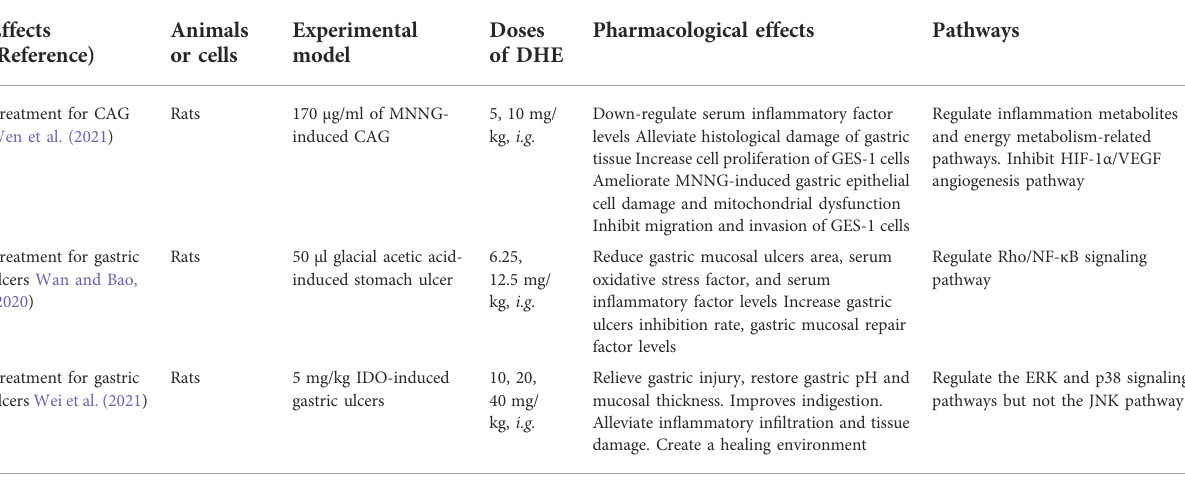
TABLE 3 Pharmacological activities of DHE in the digestive